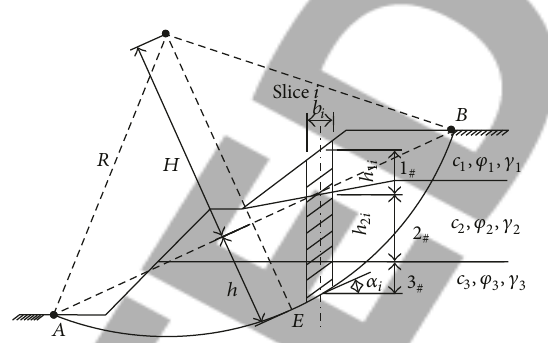
Figure 1: Theoretical model for deducing the safety factor of